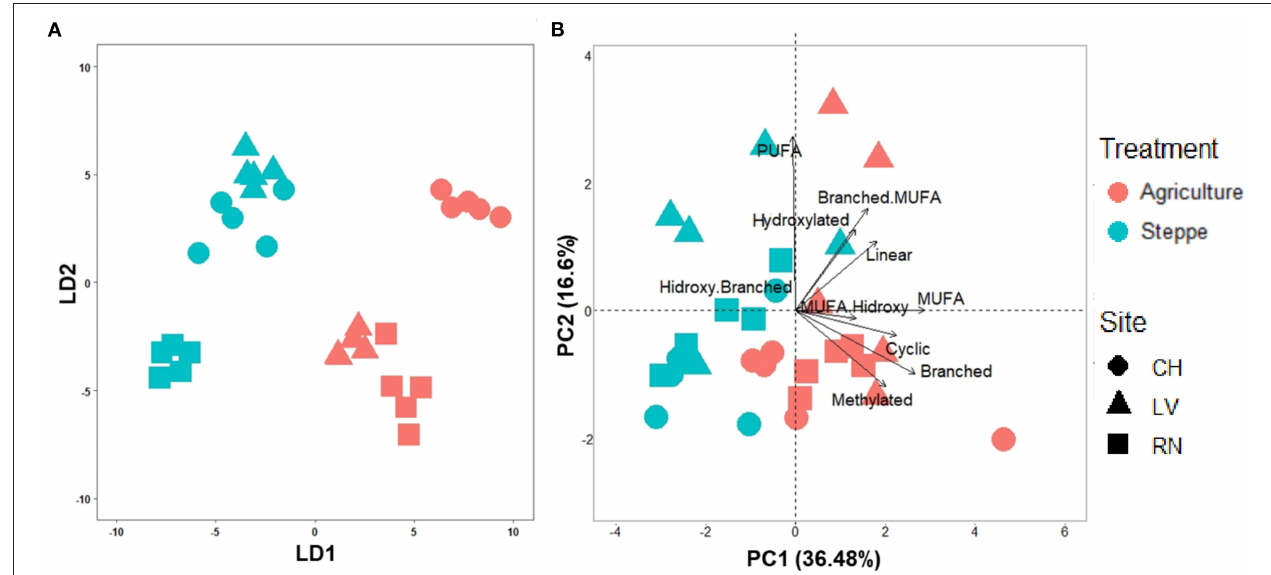
FIGURE 3 | (A) Lineal discriminant analysis (LDA) plots for the soil samples considering the trimmed fatty acids profile (49 fatty acids), and (B) Principal component analysis (PCA) plot of soil samples based on fatty acids grouped by their chemical functions for irrigated agriculture and steppe soils.